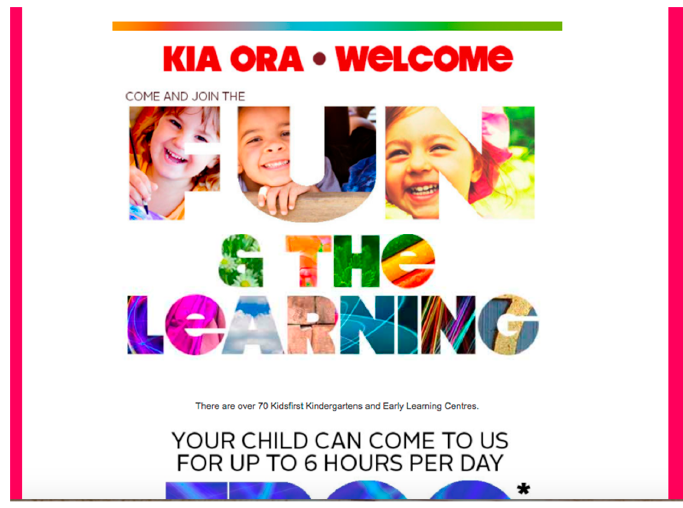
Figure 3. Screenshot of one early childhood education (ECE) centre website with bilingual welcome.